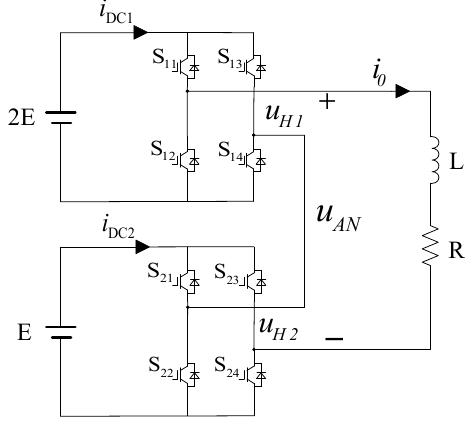
Figure 1. Topology of hybrid seven-level inverter.